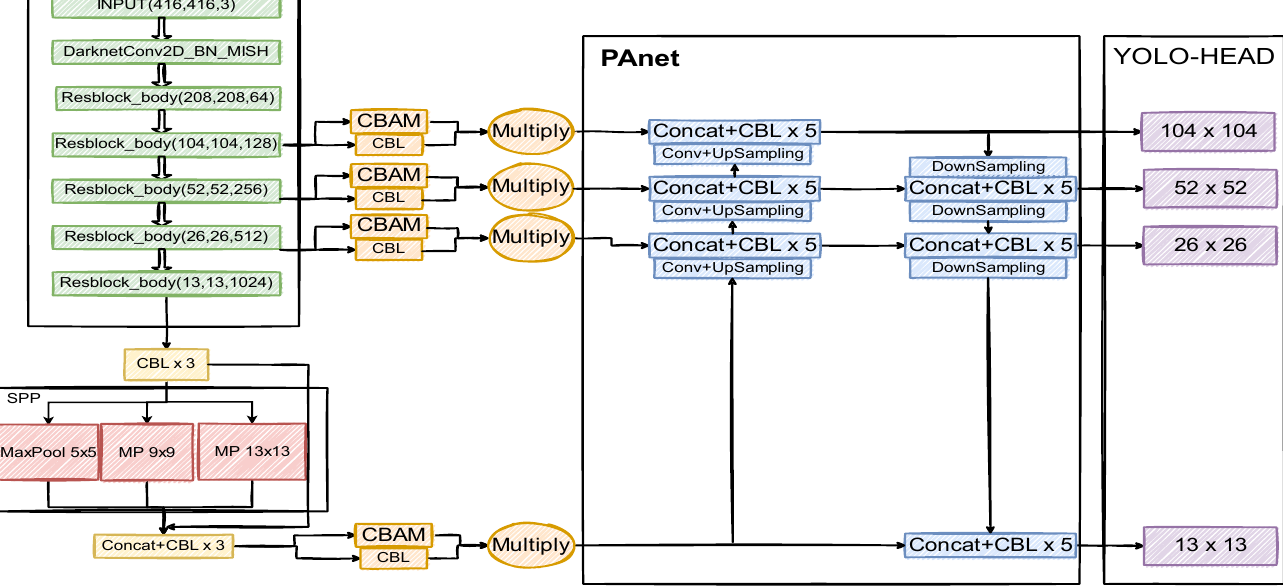
Figure 4. Spatial attention module.